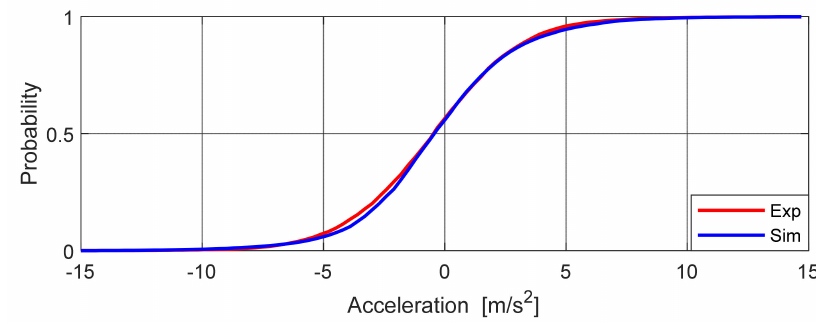
Figure 38. Distribution function, acceleration on vehicle RA.